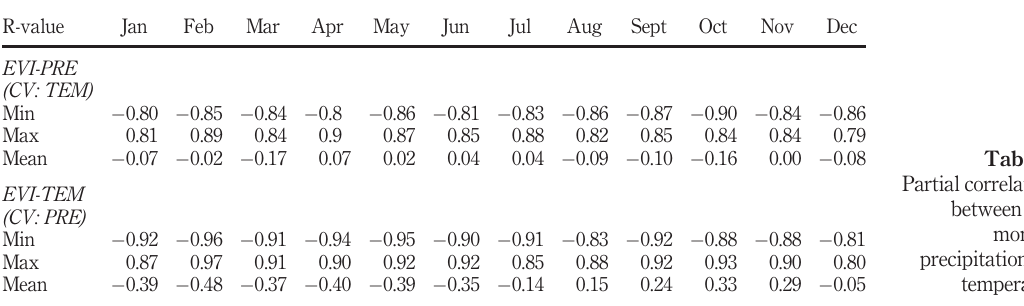
Figure 6. EVI percentages of SOS, EOS, and LOS at different elevations (a) and slope gradients (b)